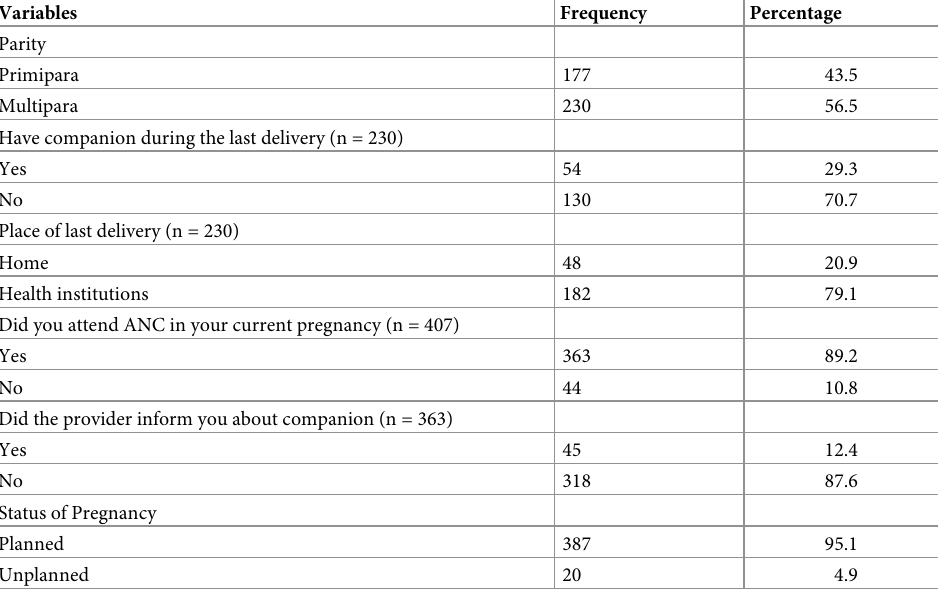
Table 2. Obstetrics characteristics of women who give birth in Arbaminch town public health facilities southern Ethiopia, 2019.